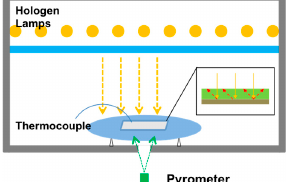
Figure 1. Rapid Thermal Annealing system.